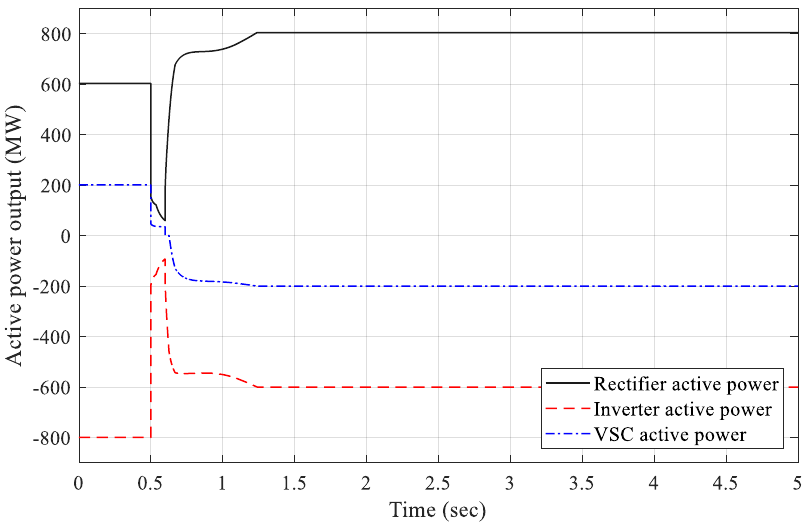
Figure 13. The active power output for each converter for the generation side event with the operation strategy.